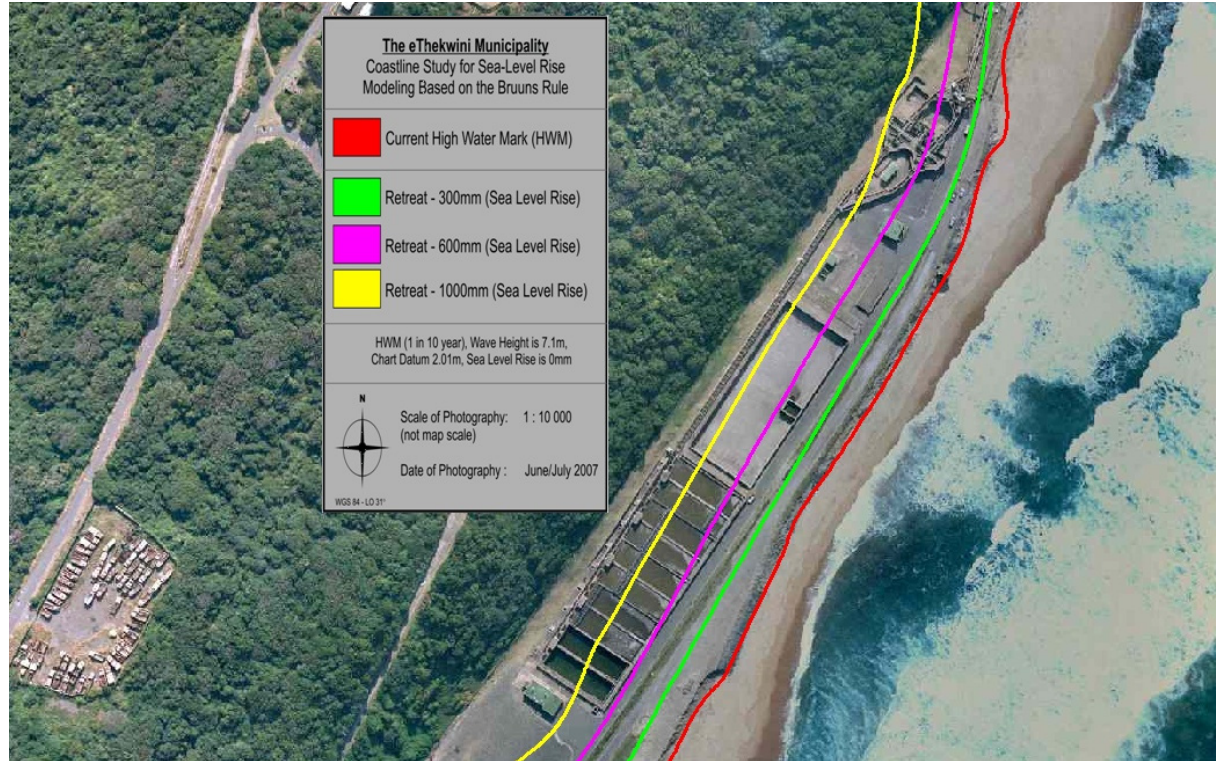
Figure 7. Sea level rise scenarios for the Central sewerage treatment works in Durban [48].